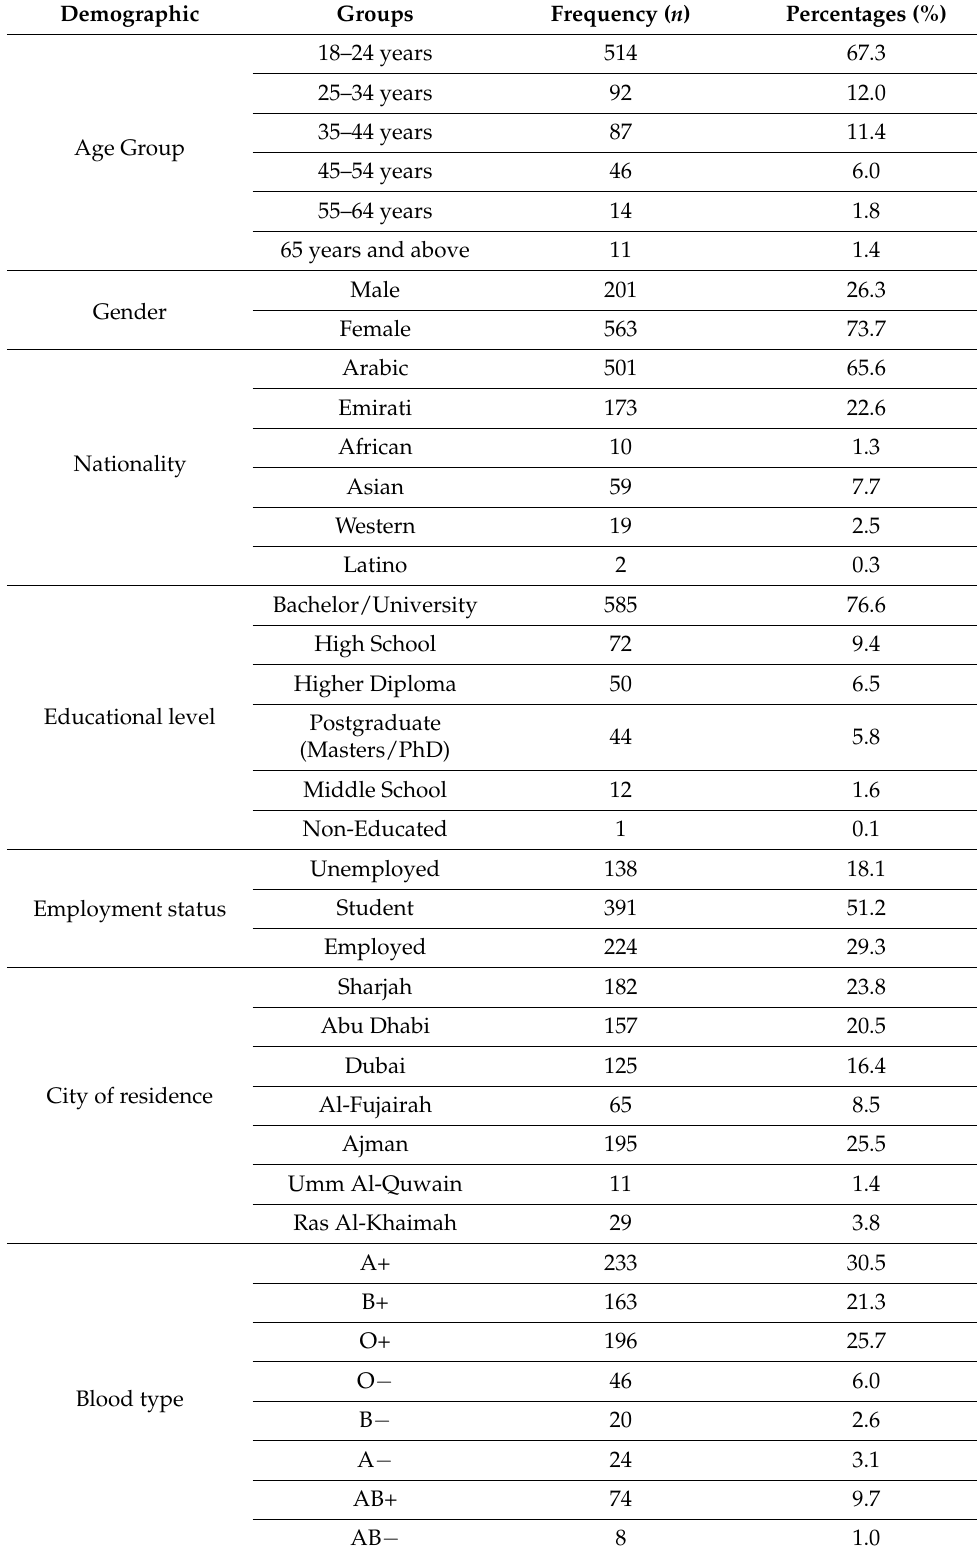
Table 1. Number and percentages of the questions on demographic information ( n =